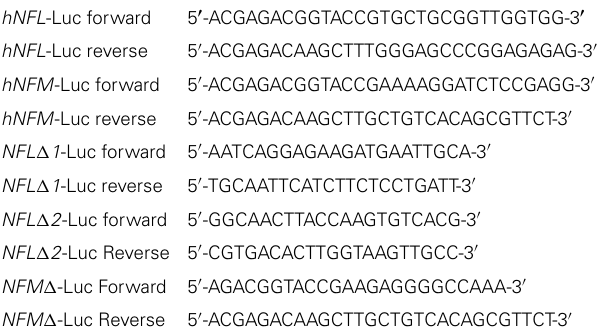
Table 1 | List of primers used for cloning promoter luciferase constructs and the mutants thereof. hNFL -Luc forward